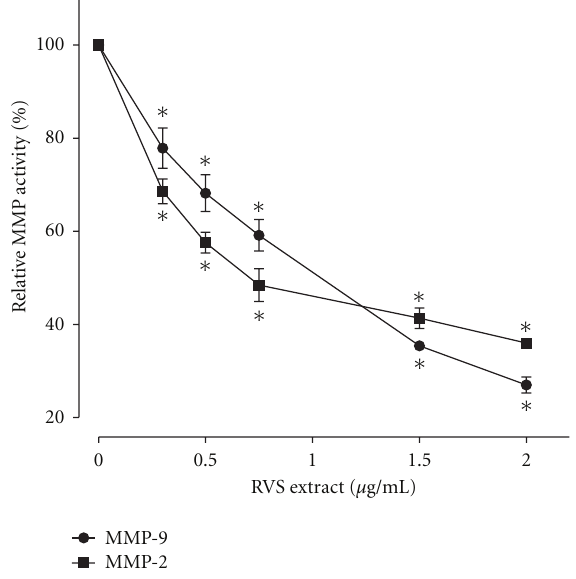
Figure 4: The e ff ect of the standardized RVS extract on matrix met- alloproteinase (MMP) activities by spectrofluorometric method. The IC 50 of the standardized RVS extract for MMP-2 and MMP- 9 was 1.01 ± 0.07 μ g/mL and 1.94 ± 0.11 μ g/mL respectively. ∗ P < 0 . 05 versus respective